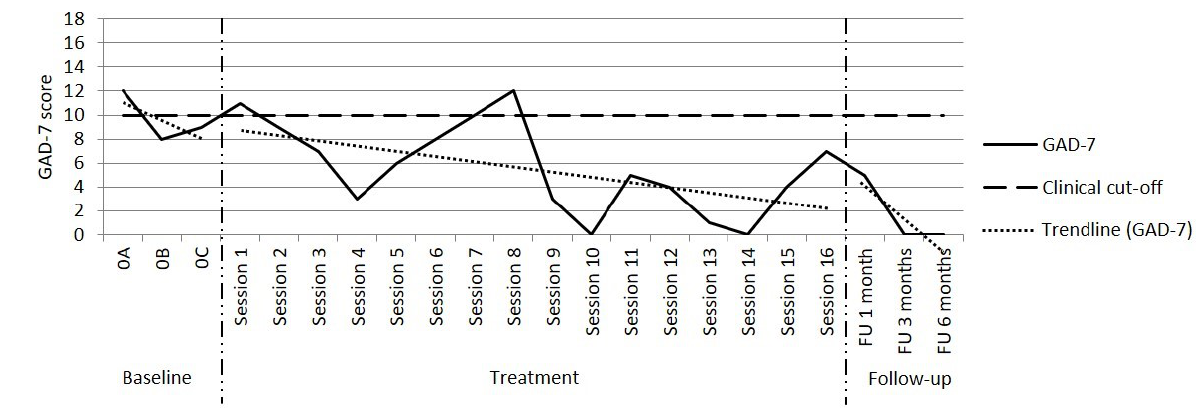
Note . 0A, 0B and 0C = assessment sessions. FU = follow-up. GAD-7 = Generalized Anxiety Disorder 7-item (Spitzer, Kroenke,